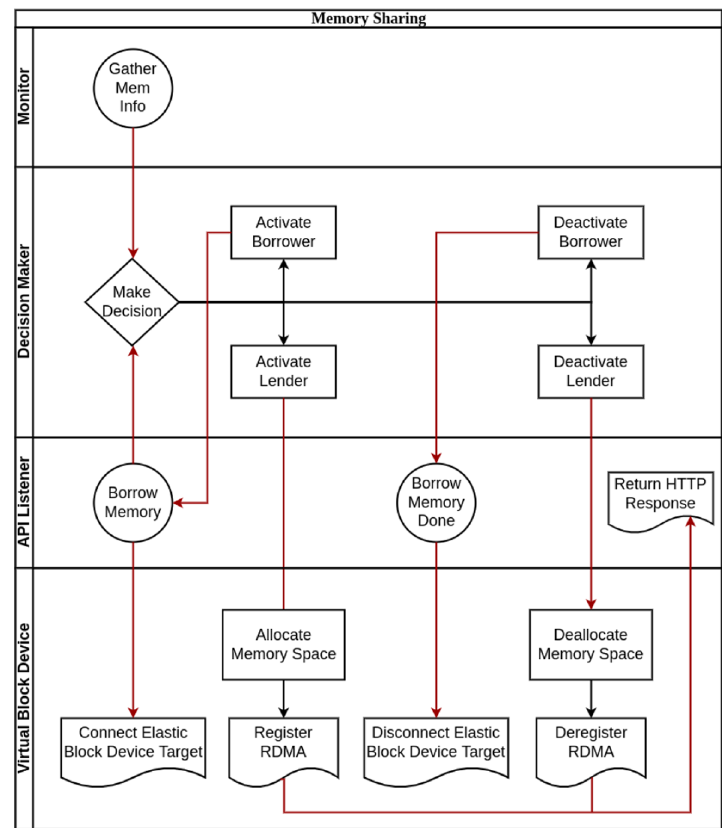
Fig. 8 System logic in swim‑lane